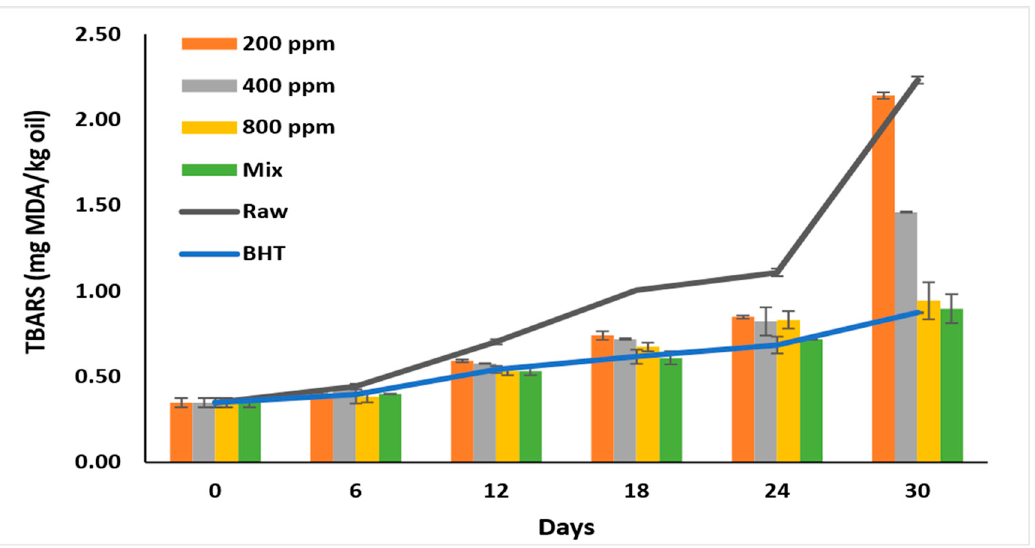
Figure 6. TBARS value (mg MDA/kg oil) of raw soybean oil (without antioxidants) and soybean oil enriched with PGG leaves extract (200, 400, and 800 ppm), BHT (200 ppm), and a PGG/BHT mixture (400/100 ppm) during the accelerated storage days (30 days) at 65 °C.